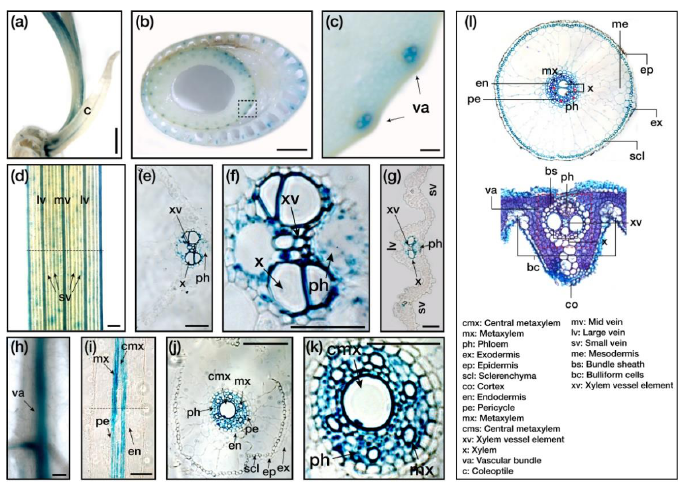
Figure 5. Histochemical analysis of OsERF83 . ( a ) The OsERF83 expression in different tissues of the OsERF83::GUS transgenic rice plants by GUS staining analysis, in the coleoptile of 5-day-old seedlings ( a ), stem cross-sections of 2-month-old plants ( b , c ), leaves of 2-week-old plants ( d ), leaf cross- sections of 2-week-old plants ( e , g ), the root of a 5-day-old seedling ( h ), longitudinal root section of 2-week-old plants (I), and root cross-sections of 2-week-old plants ( j , k ). Scale bars represent 1 mm in ( a , b ), 100 µm in ( c , d ) and ( h ), and 50 µm in ( e – k ). ( i ) Transverse section images represent struc- tures of the roots and leaves.